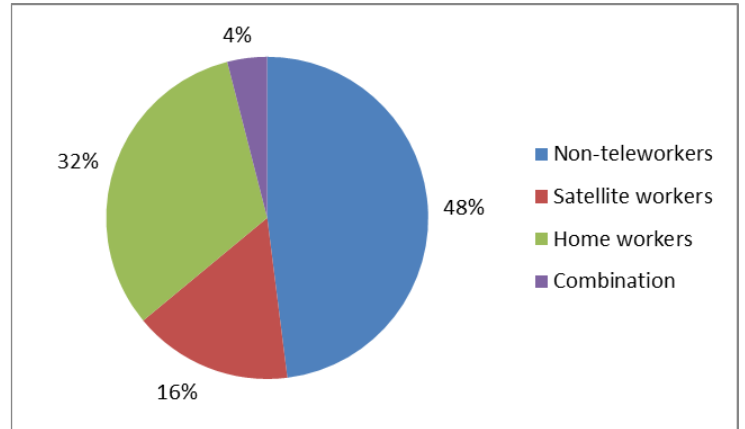
Figure 1. Distribution of respondents by type of telework (n=1247) (MOBI,